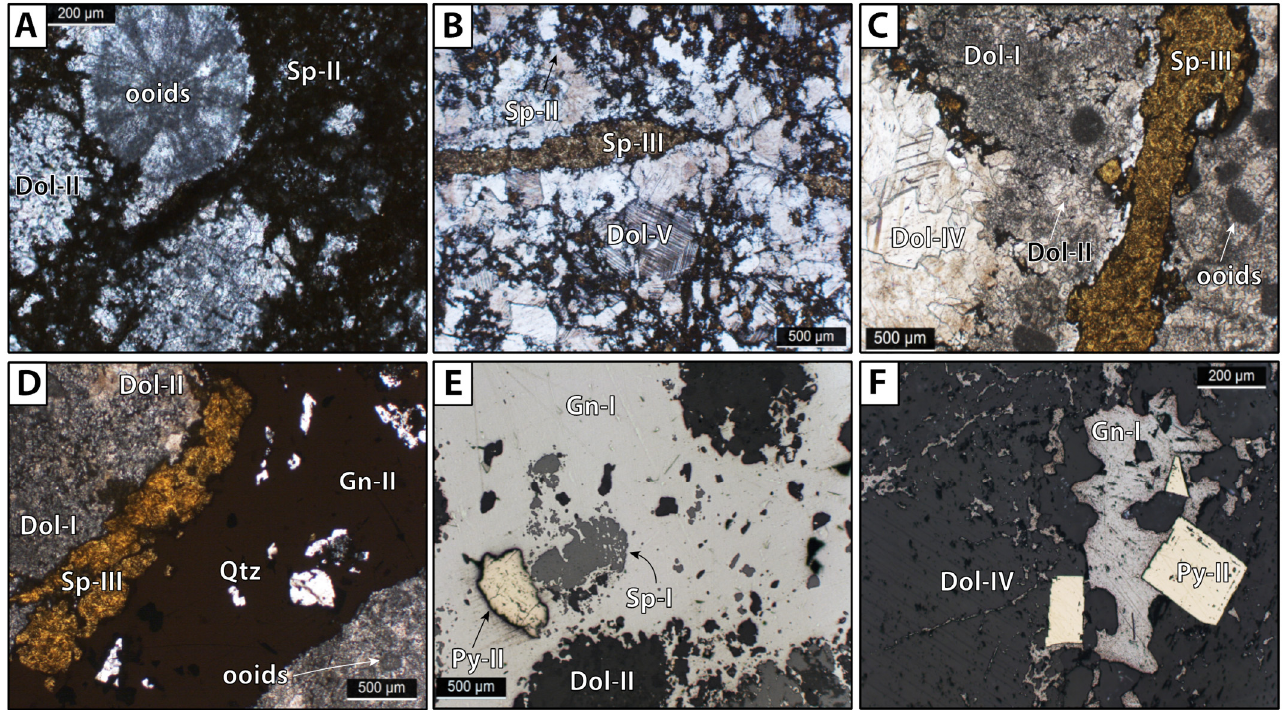
Figure 7. Photomicrographs of mineralogy and textural relationships of mineralized samples in the Morro Agudo district from the later stages of mineralization. Samples A,C,D,E are from the JKL orebody, B is from the Basal orebody, and F is from Morro do Capão (PPL = plane polarized light; RL = reflected light). ( A ) Fine-grained, black sphalerite (Sp-II) overprinting and replacing the margin of dissolved ooids and sparitic dolomite (Sample ID = MA580-033–30; PPL). ( B ) Veinlet of late sphalerite (Sp-III) cross-cutting coarse hydrothermal dolomite (Dol-V) and fine-grained black sphalerite (Sp-II) (Sample ID = MA580-030–28; PPL). ( C ) Veinlet of late sphalerite (Sp-III) cross-cutting sparitic (Dol-I) and micritic (Dol-II) dolomite with remnant ooids (Sample ID = MA580-033–30; PPL). ( D ) Late-stage galena (Gn-II) and sphalerite (Sp-III) cross-cutting micritic (Dol-I) and sparitic dolomite (Dol-II) and remnant ooids (Sample ID = MA580-053–30; PPL). ( E ) Coarse galena (Gn-I) filling corroded zones in sphalerite (Sp-I) and sparitic dolomite (Dol-II) (Sample ID = MA580-053–30; RL). ( F ) Interstitial galena (Gn-II) and euhedral pyrite (Py-II) infilling saddle dolomite (Dol-IV) (Sample ID = MC-PMC-05–20; RL).